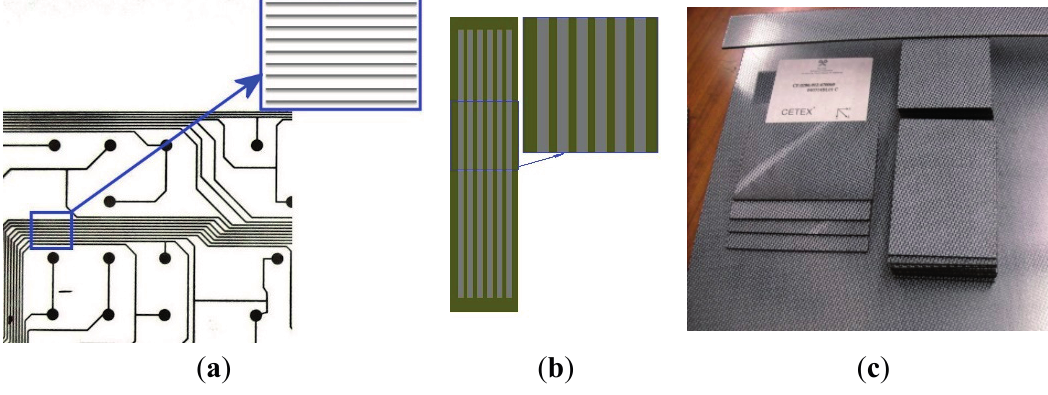
Figure 3. Studied samples: ( a ) MSGs from flexible printed circuit; ( b ) MSGs realized with polyimide support; ( c ) Plates from